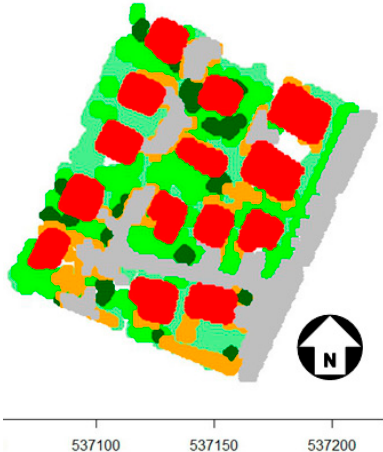
Figure 14. Enhanced land cover map of six classes (Level 1). (red = “building”, light green = “grass”, dark green = “tree”, green = “hedge and bush”, grey = “road and parking lot”, orange = “wall and car port”; the numbers below the map represent meters). Adapted from [12].